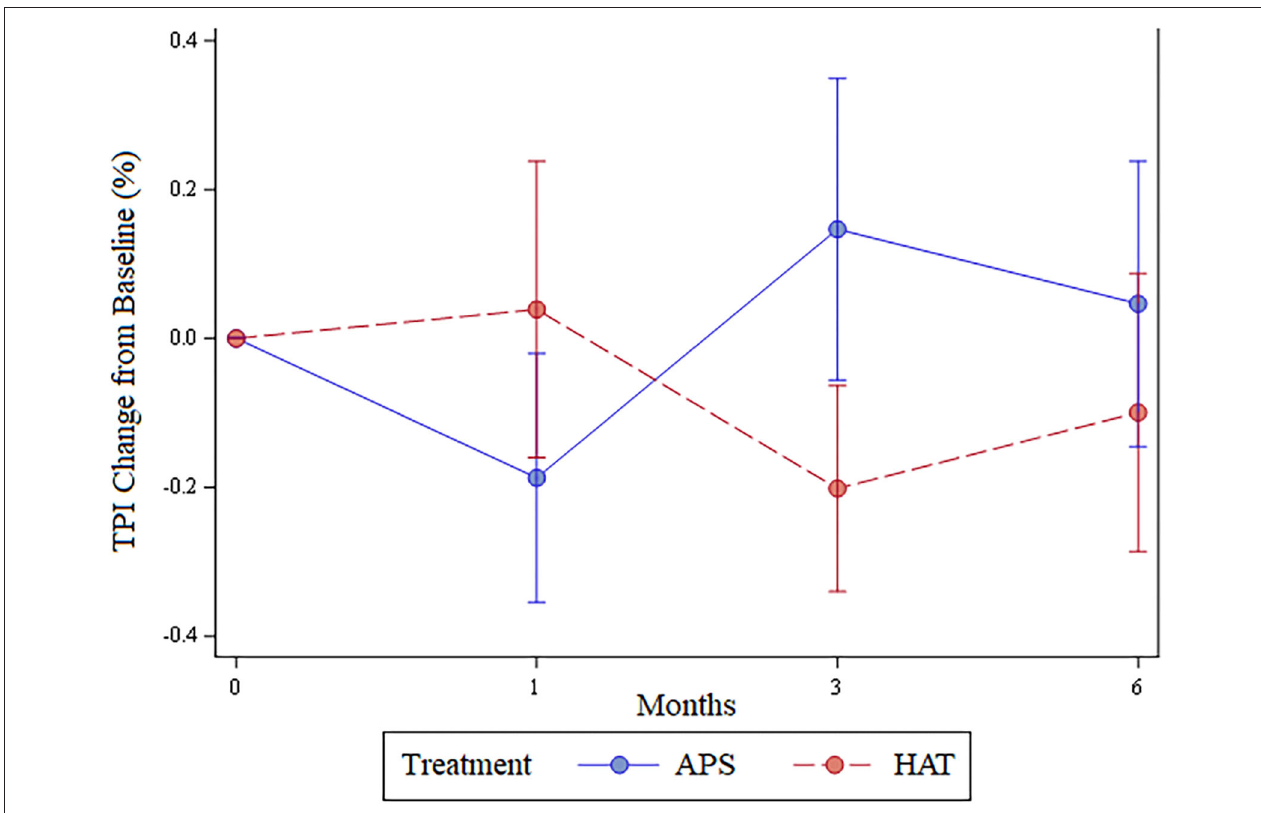
FIGURE 4 | Change in total pressure index (mean ± SE) from baseline over the 6-month study for APS and HAT treated